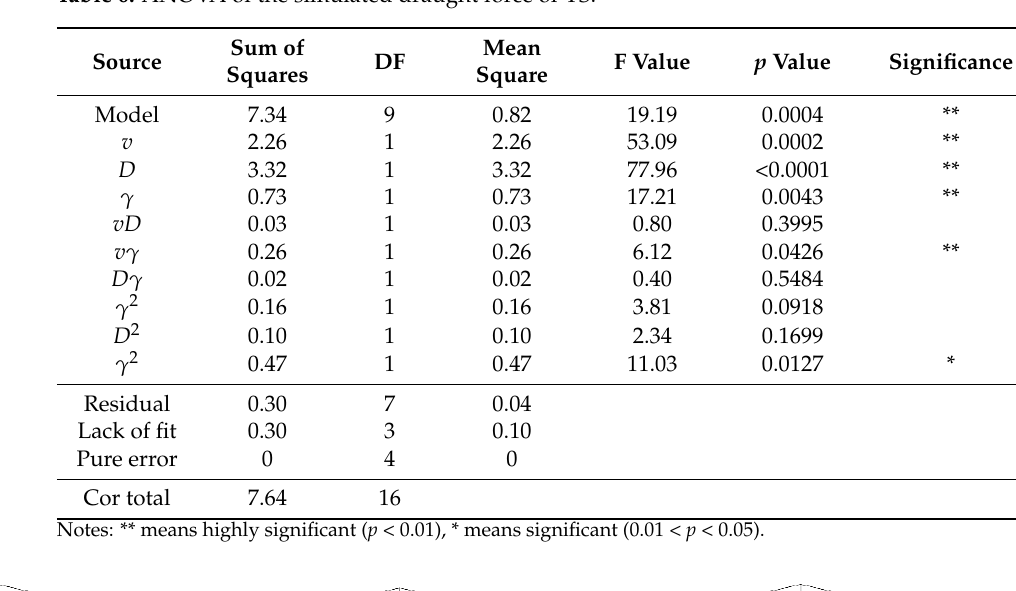
Table 6. ANOVA of the simulated draught force of YS.